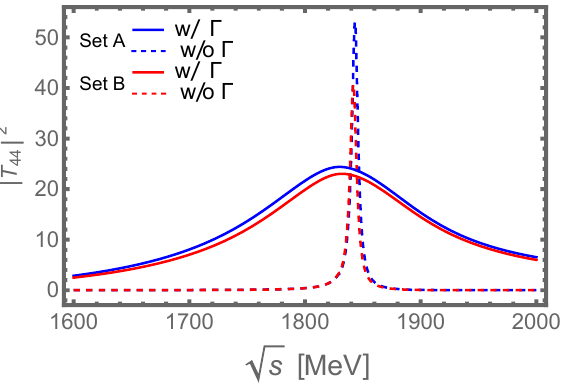
Figure 1. The blue dashed and solid lines are, respectively, the modulus squared of the T -matrix K 1 ( 1400 ) ¯ K transition, evaluated with and element, corresponding to the diagonal K 1 ( 1400 ) ¯ K → without the inclusion of the widths associated with the axial-vector mesons taking part in the loop function G l (Equation (20)).